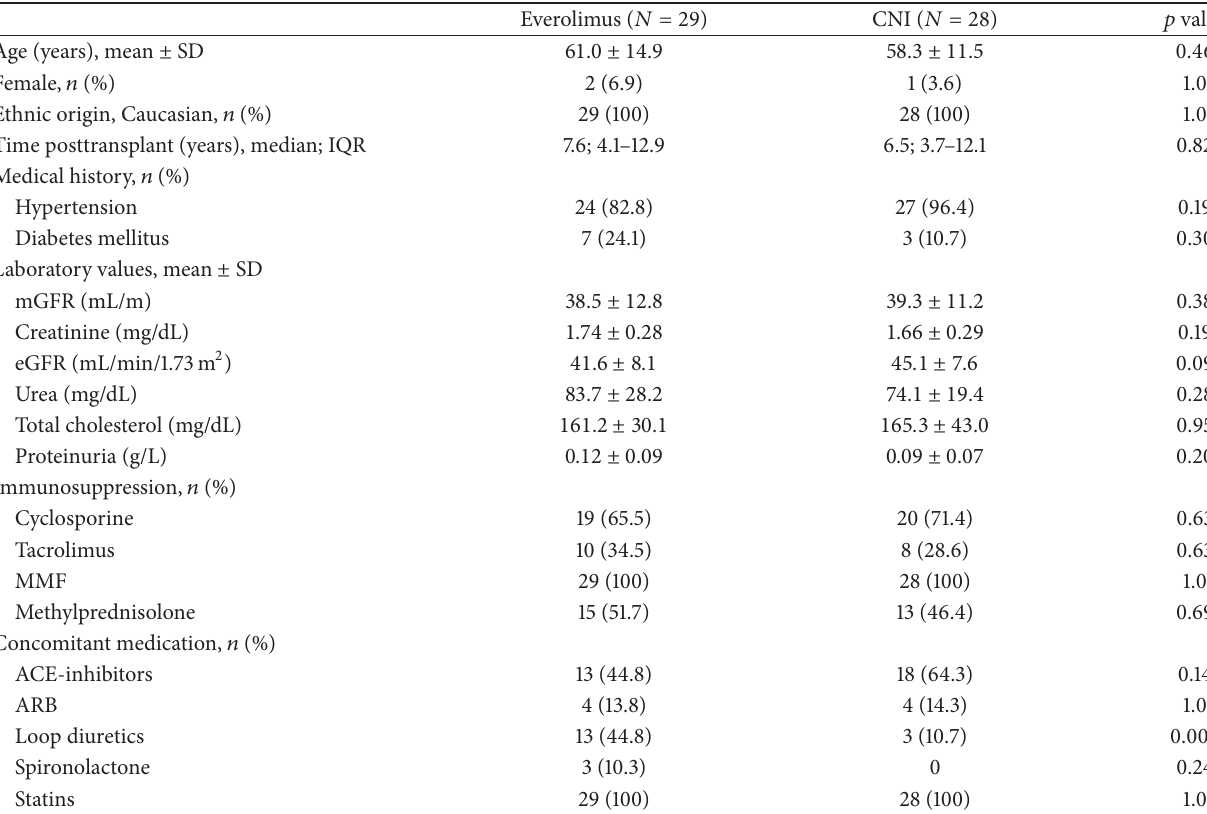
Table 1: Baseline